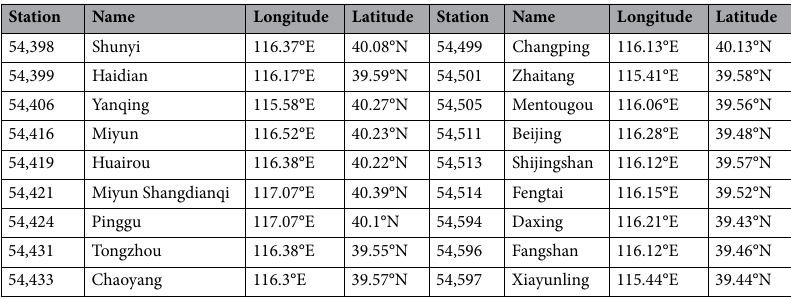
Table 2. Information of meteorological monitoring stations in